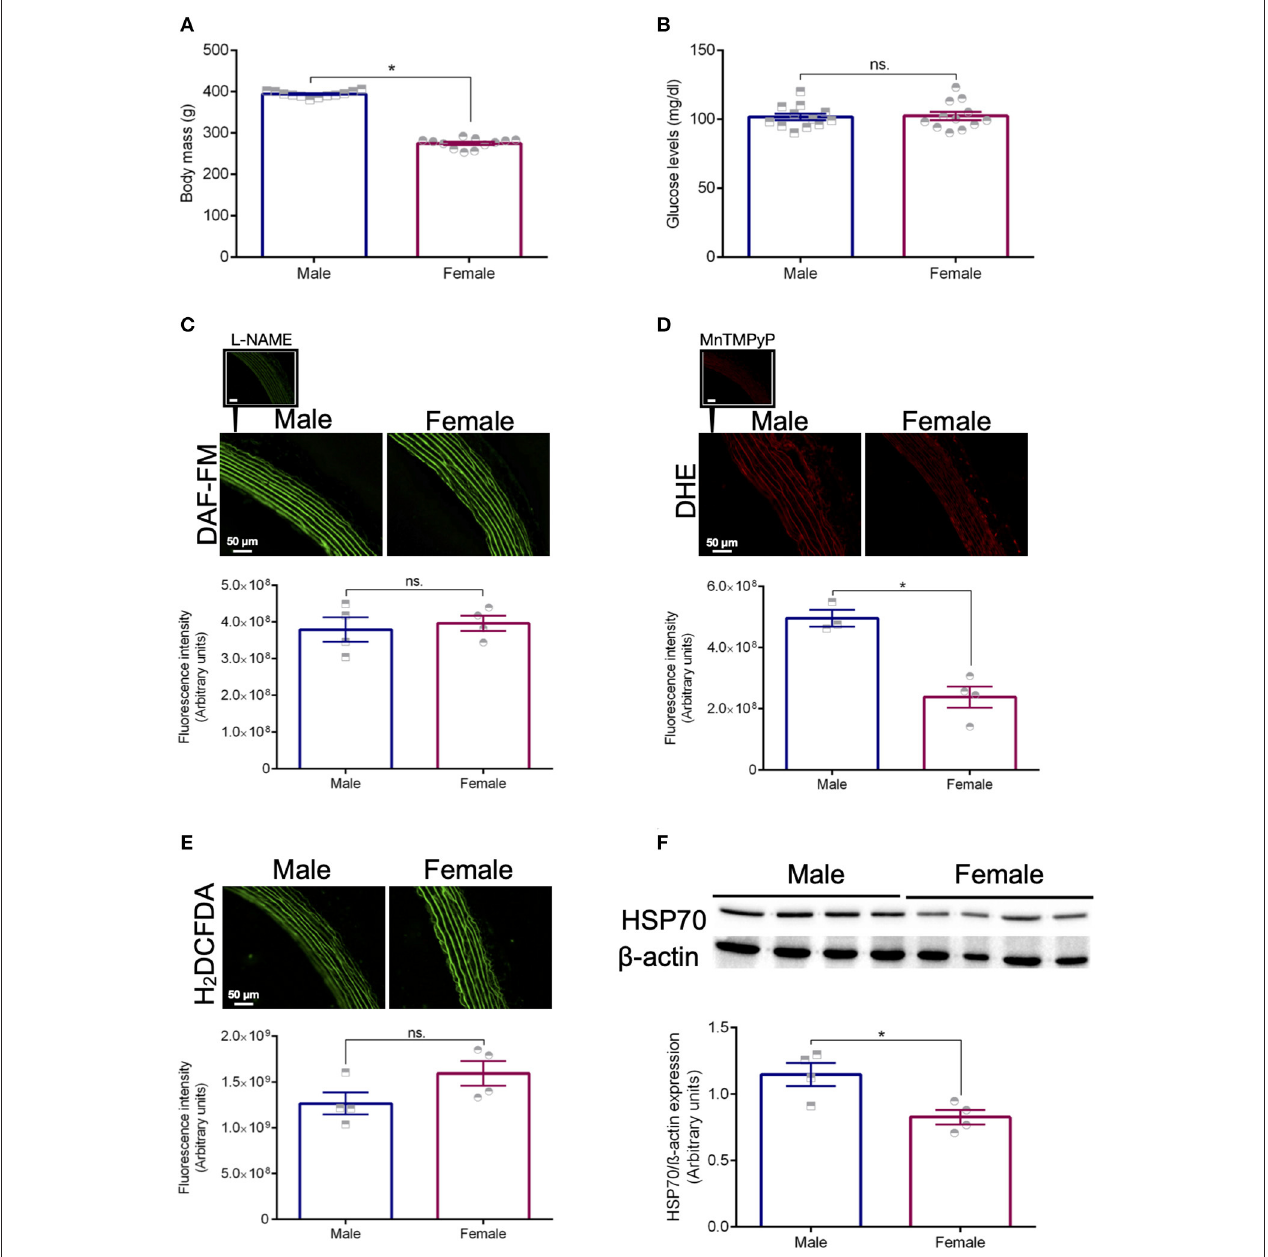
FIGURE 1 | Animal profile. Body mass (A) and glucose levels (B) . The fluorescent probes DAF-FM (C) , DHE (D) , and H 2 DCFDA (E) were used to measure the levels of nitric oxide and vascular oxidative stress in isolated thoracic aortas from male and female Sprague Dawley rats. L-NAME (10 -6 mol/L, NOS inhibitor) was used as a negative control for DAF-FM and MnTMPyp (25 µ mol/L, superoxide dismutase mimetic) was applied to control for the specificity of the DHE probe. Expression levels of HSP70 after normalization to β -actin (F) . Data are expressed as mean ± SEM, n = 4 except for the male group in (D) ( n = 3). * p ≤ 0.05 using two-tailed Student’s t